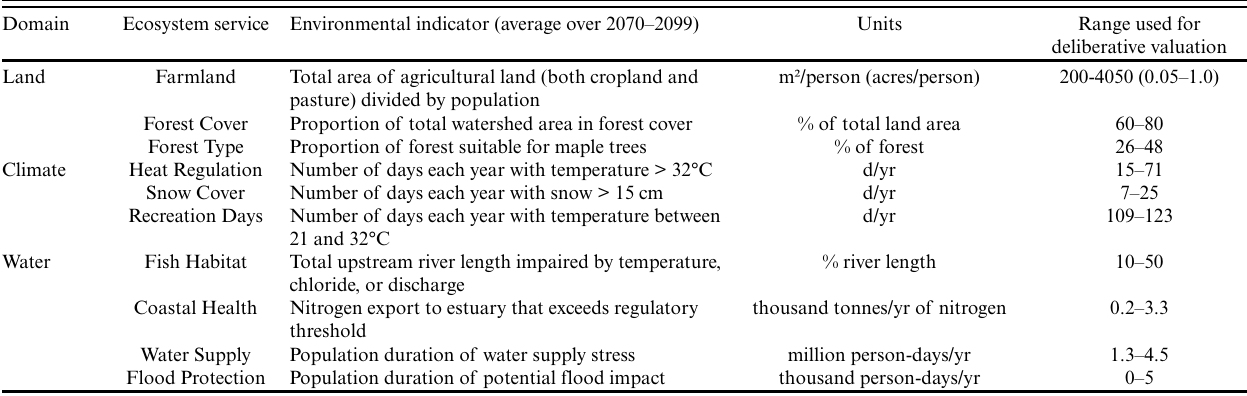
Table 1. Ecosystem services, corresponding environmental indicators, and evaluated range (Mavrommati et al. 2016).